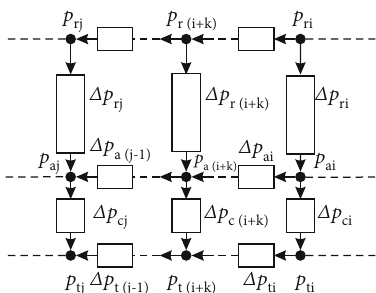
Figure 5: Flow-node unit of type